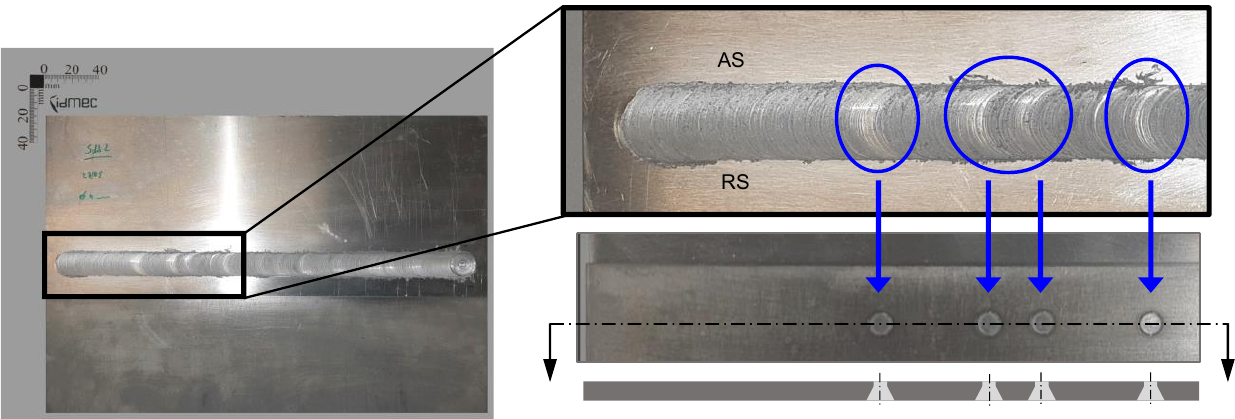
Figure 5. Detail top of joint E4, with highlight observing the ‘color bands’ which correspond to the holes where the material was drained.